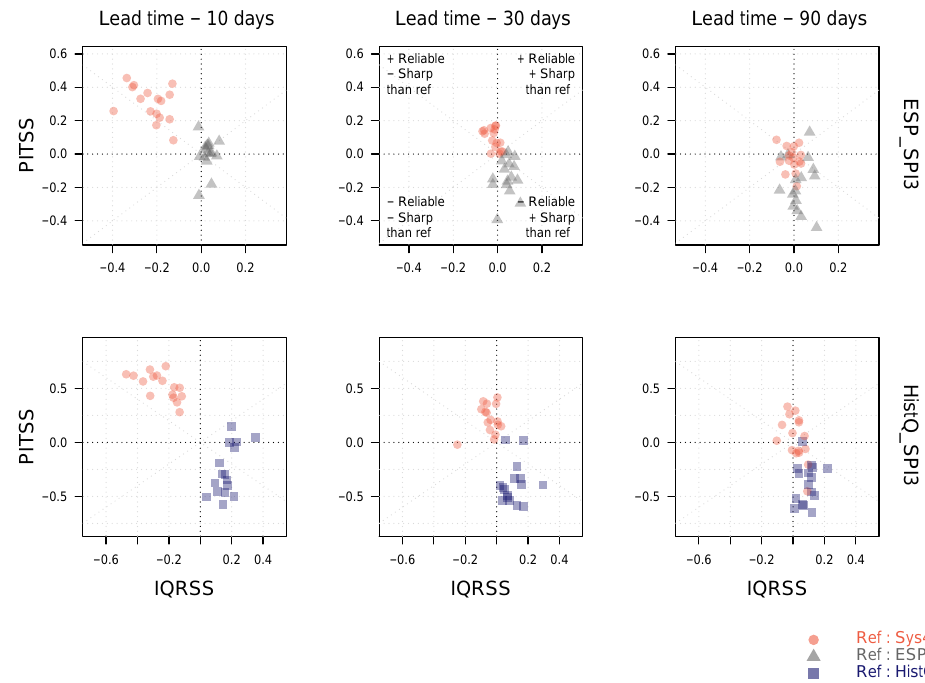
Figure 7. PITSS (reliability) versus IQRSS (sharpness) for ESP_ SPI3 (upper row) and HistQ_SPI3 (lower row), and lead times of 10, 30 and 90 days (columns). ESP_SPI3 is compared to Sys4 (red) and ESP (grey), while HistQ_SPI3 is compared to Sys4 (red) and HistQ (blue). Each point represents one of the 16